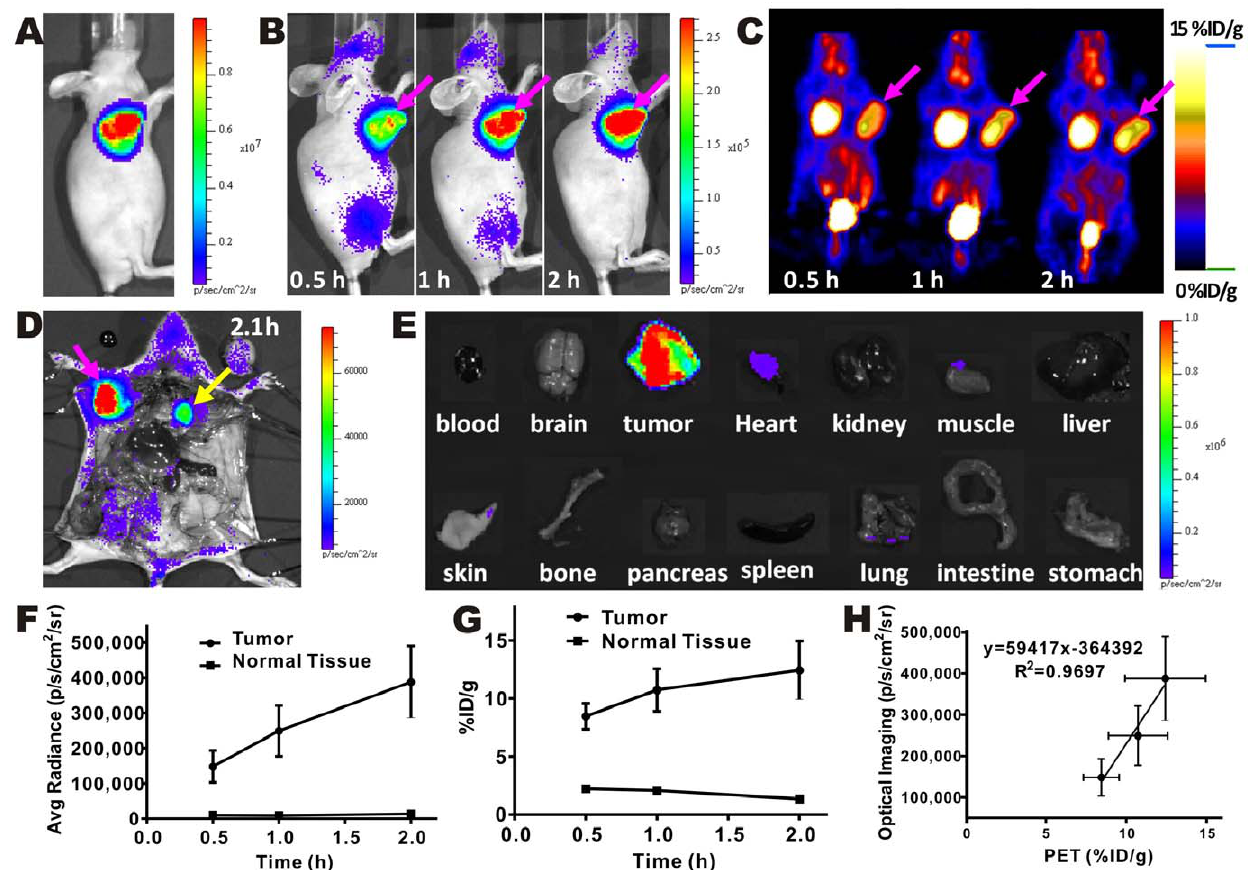
Figure 3. Invivo radioactive OI of [ 18 F]FDG in comparison with microPET. ( A ) Bioluminescence image of a nude mouse bearing C6-FLuc tumor. ( B,C ) Radioactive OI and microPET imaging of a nude mouse bearing C6-FLuc tumor injected via tail vein with [ 18 F]FDG at 0.5, 1, 2 h p.i. ( D,E ) Radioactive OI of the mouse after opening the thorax ( D ) and exposure the organs ( E ) at 2.1 h p.i. ( F–H ) Quantitative analysis of radioactive OI ( F ) and microPET ( G ) results and their correlation ( H ).